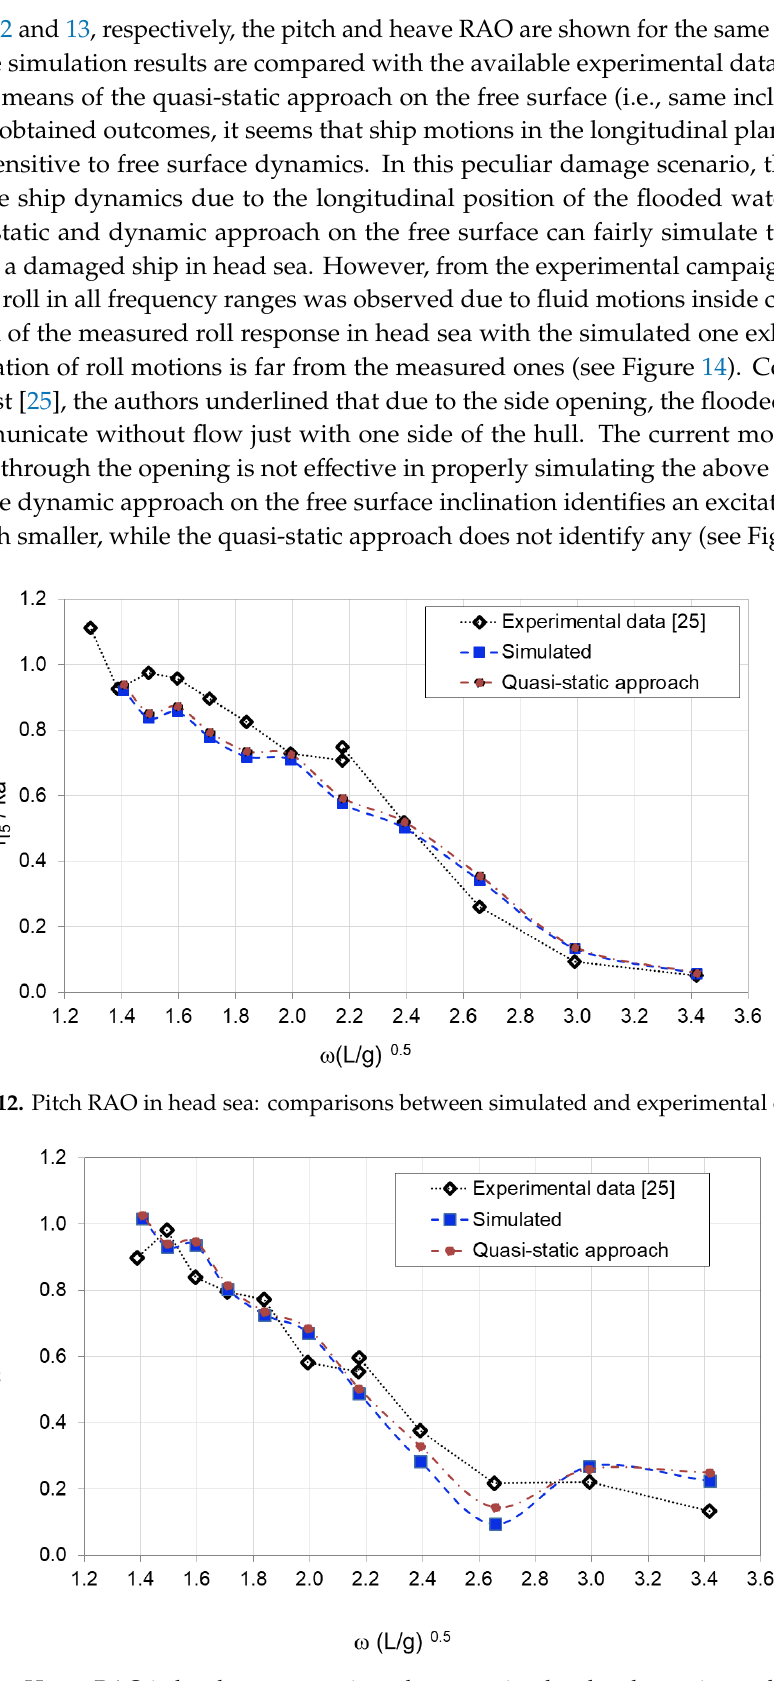
Figure 13. Heave RAO in head sea: comparisons between simulated and experimental data.